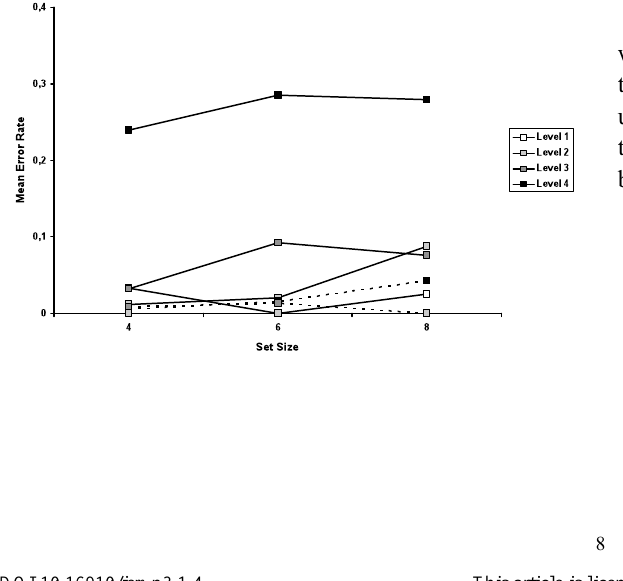
ure 6 points out the course of reaction times: As expected, they increased with the level of similarity, with the num- ber of presented items, and in the absence of a